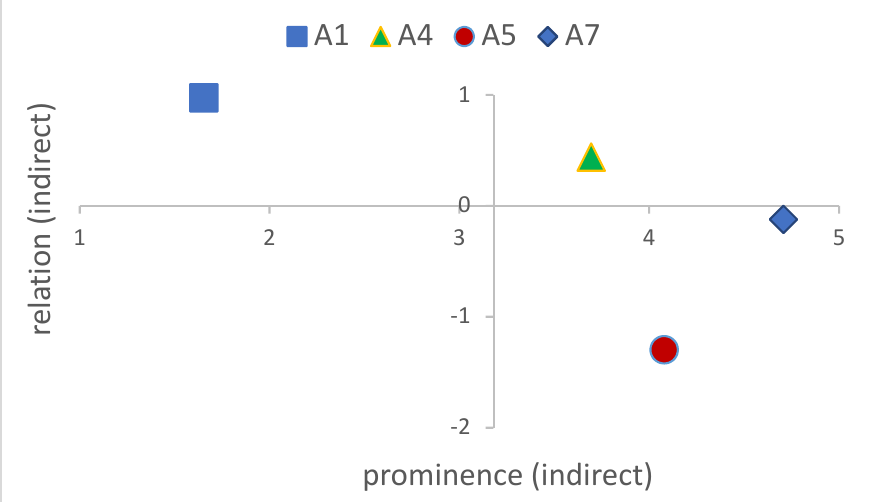
Figure 8. Results for the limited set of factors; the indirect influence Δ X case.